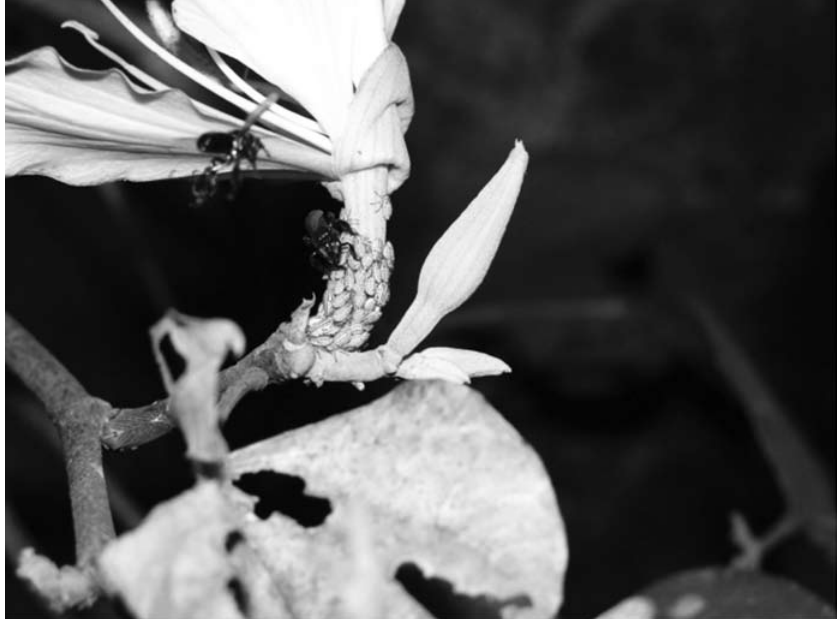
Fig. 2. T. branneri making a short flight over the A. reticulatum colony